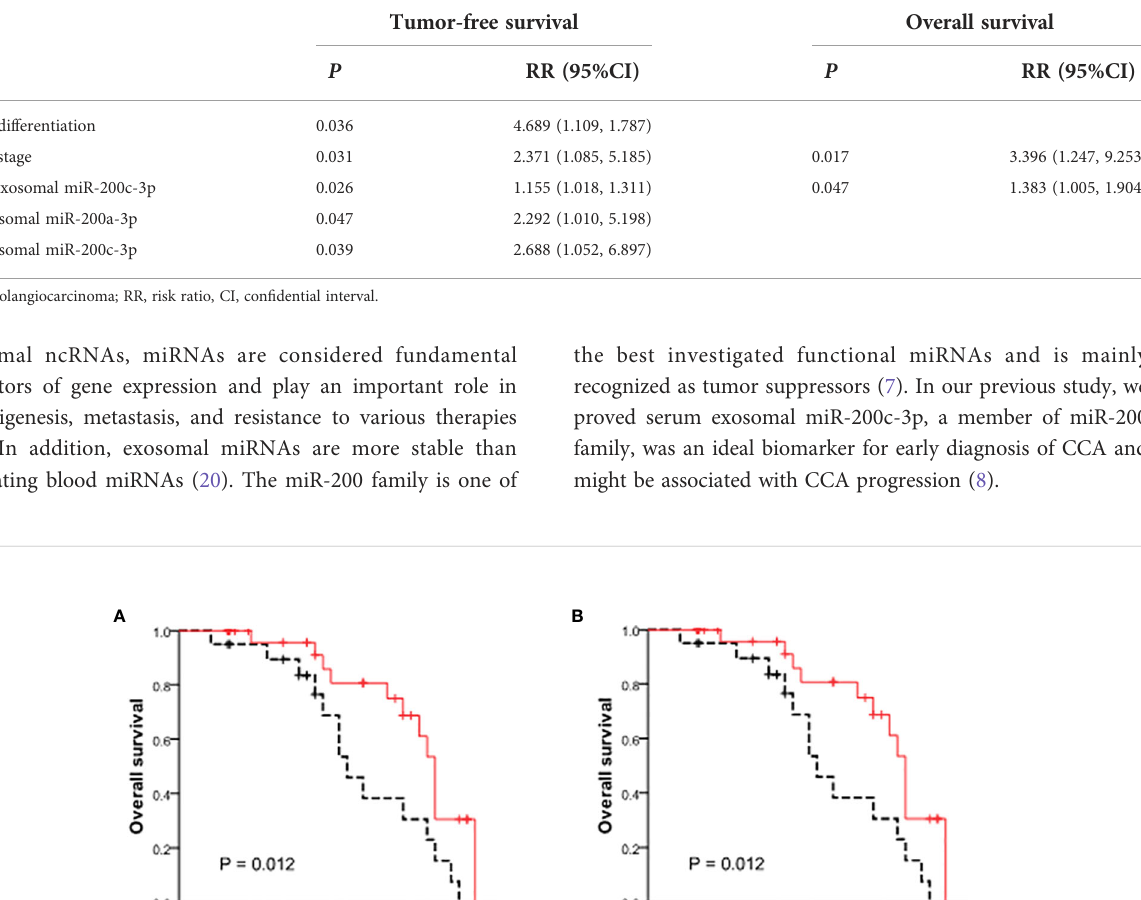
TABLE 5 In fl uencing factors of patient